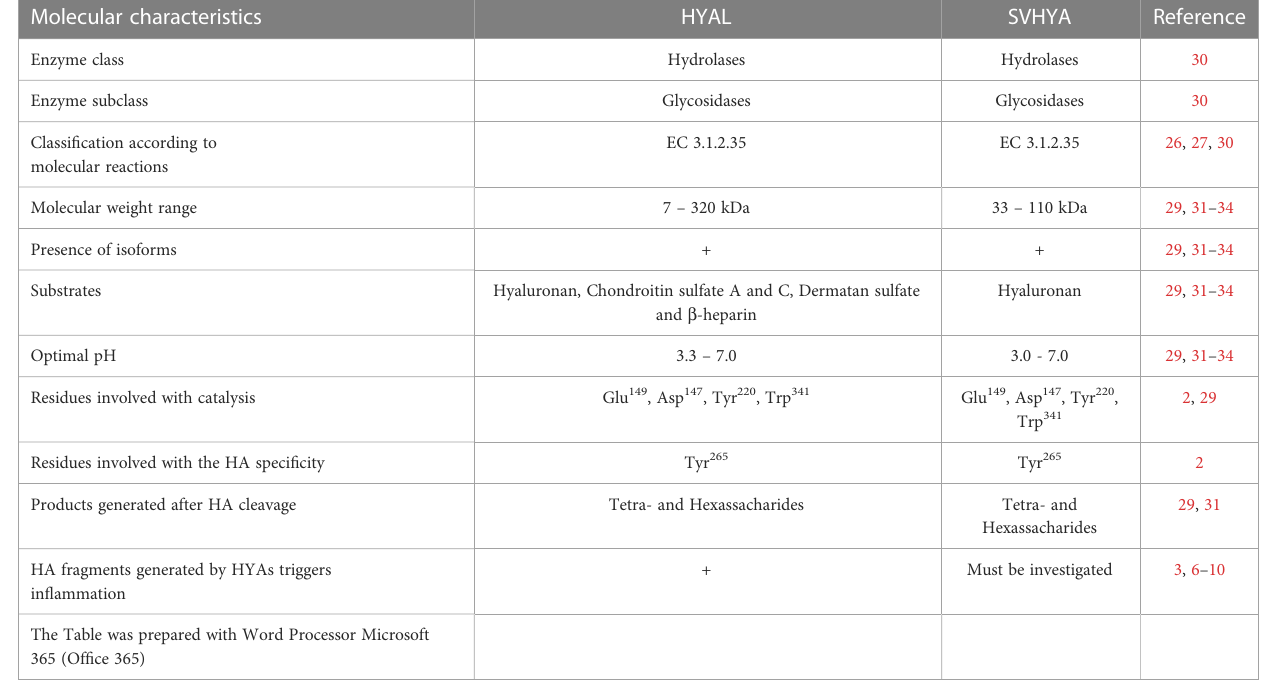
TABLE 1 Comparison between HYAL and